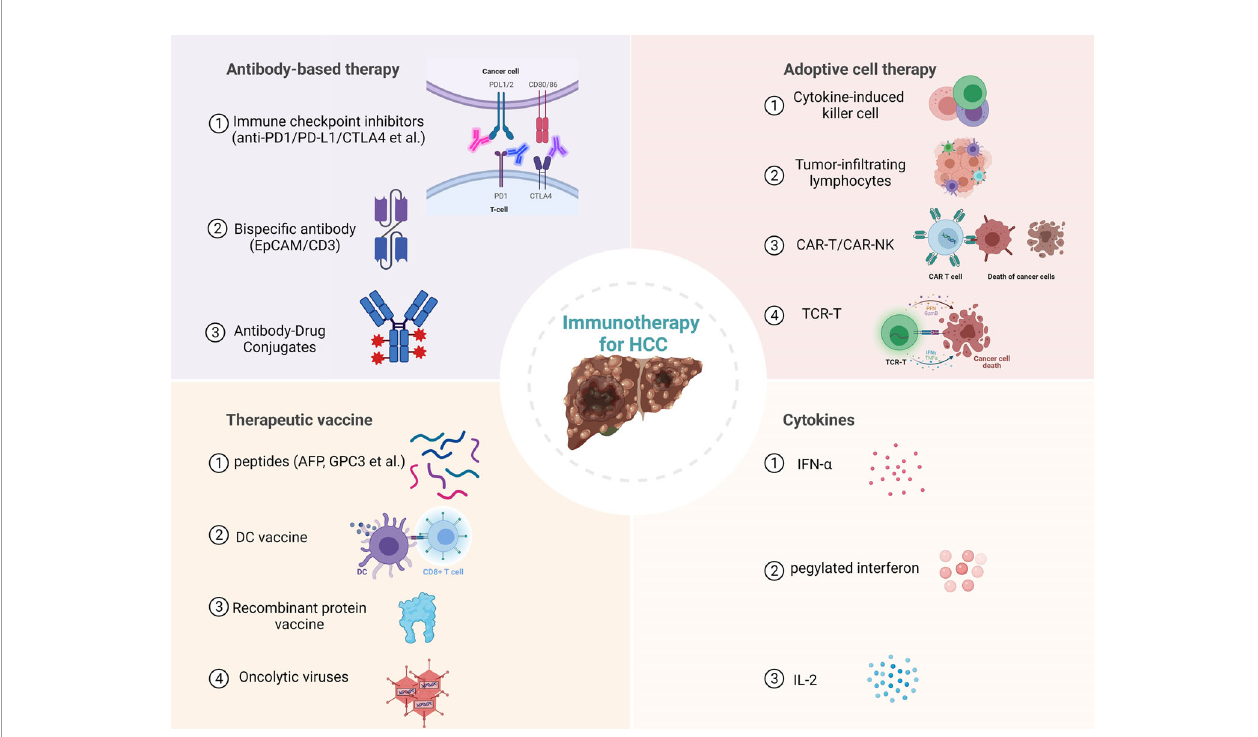
FIGURE 1 | Current immunotherapies for hepatocellular carcinoma (HCC). PD1, Programmed cell death protein 1; PD-L1, Programmed cell death ligand 1; CTLA4, cytotoxic T lymphocyte antigen 4; EpCAM, epithelial cell adhesion molecule; CAR-T, Chimeric antigen receptor T cell; NK, Natural killer cell; TCR-T, T cell receptor engineered T cell; AFP, Alpha-fetoprotein; GPC3, Glypican 3; DC, dendritic